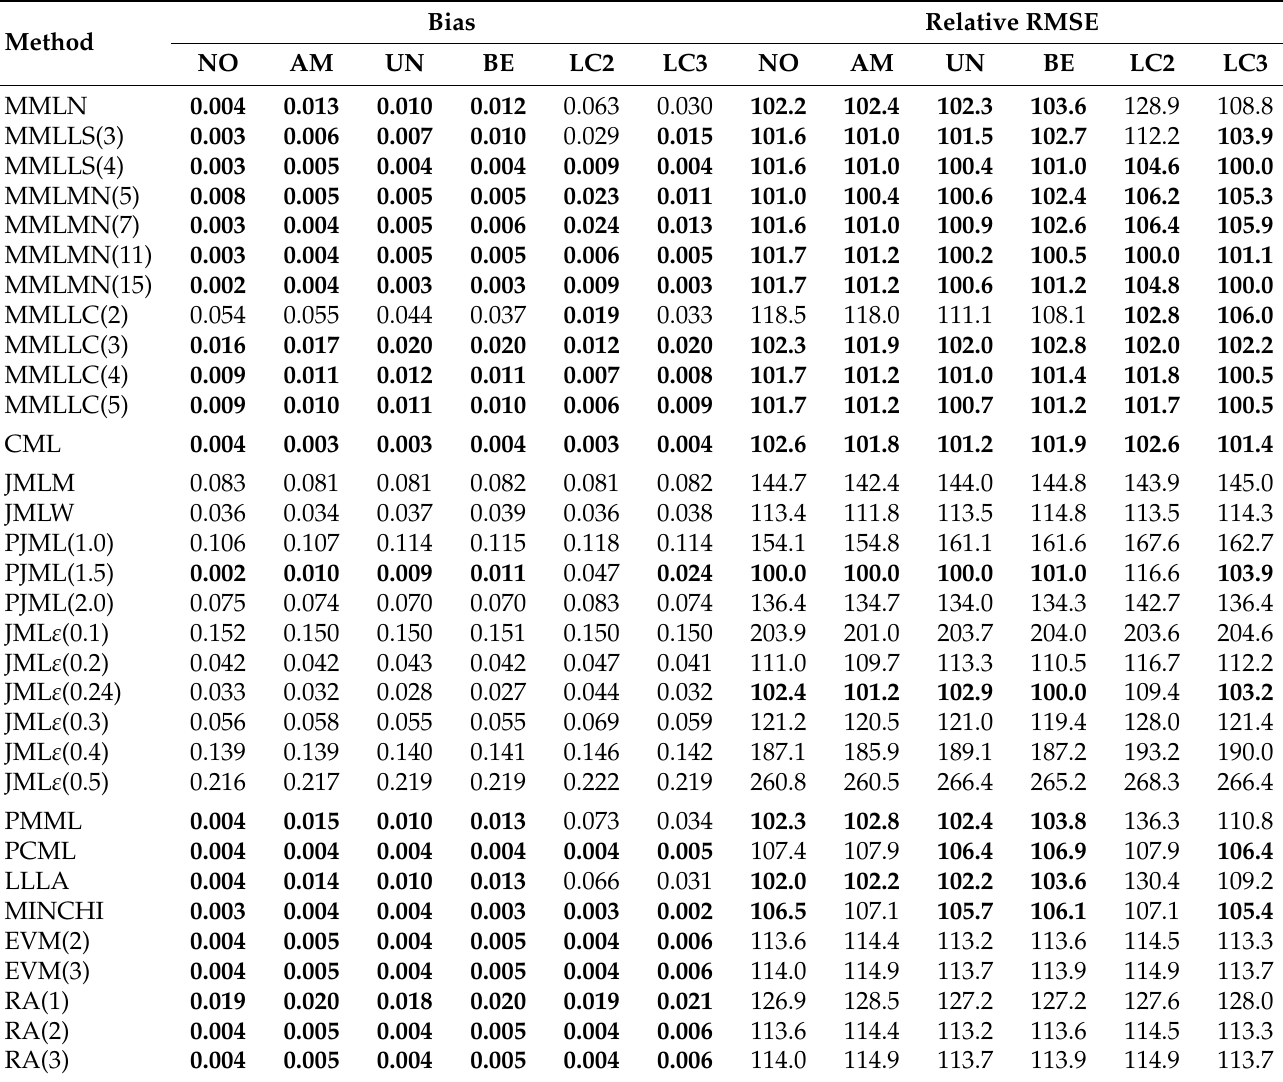
Table 3. Bias and relative RMSE for different estimation methods for a sample size of N = 1000 and I = 10 items for a test with a wide range of symmetrically distributed item difficulties as a function of the data-generating trait